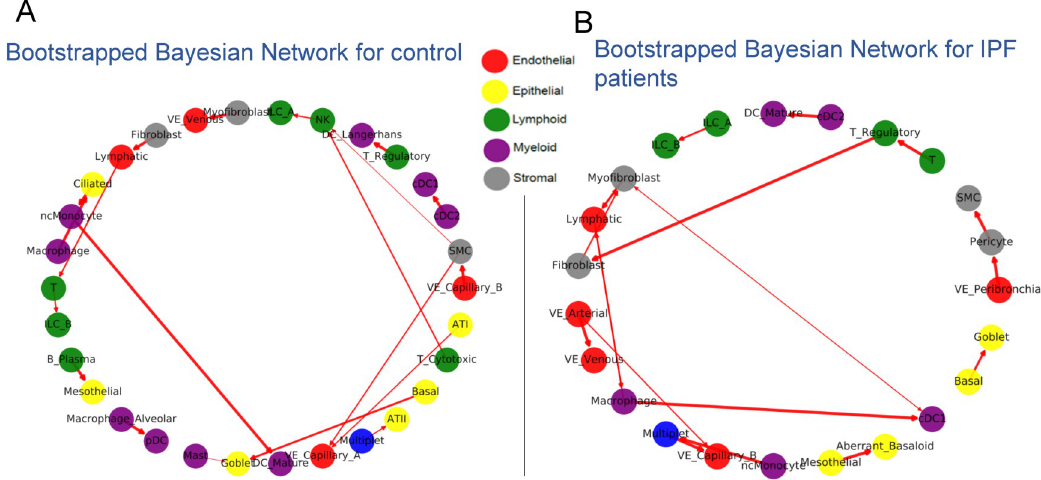
Fig 2. Bayesian Networks (BN) learned for lung cell types in healthy and IPF individual. (A) BN for controls (healthy individuals). (B) BN for IPF patients. Nodes represent specific cell types and are colored accordingly, edges represent directed interactions between the cell types. Edge width corresponds to its bootstrap